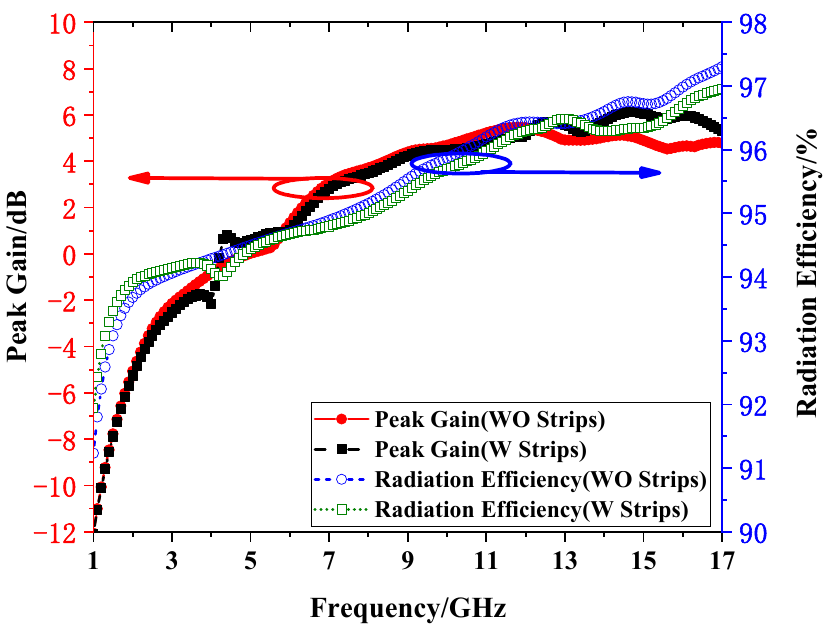
Figure 14. Gain and radiation efficiency of UWB MIMO antenna with/without introduced strips.